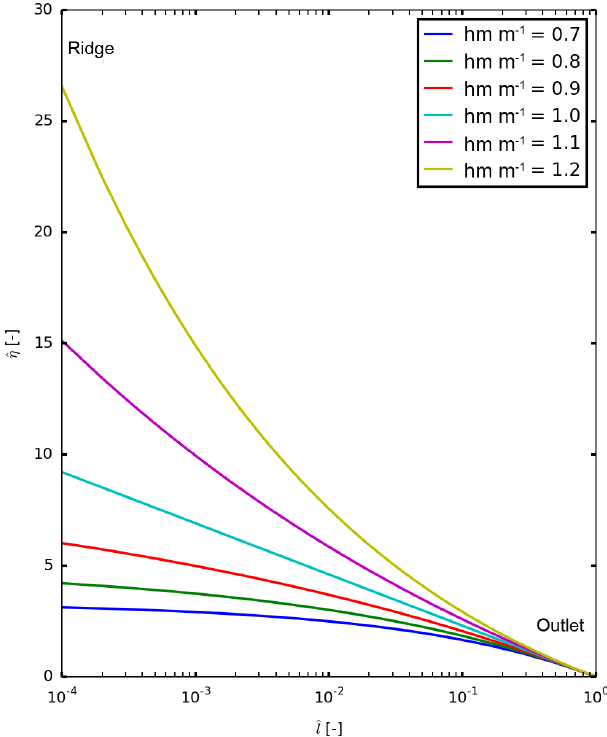
Figure 1. One-dimensional analytical dimensionless solutions for elevation profiles at steady-state equilibrium over a range of ra- tios hm/n (Hack’s Law) = 0.7, 0.8, 0.9, 1.0, 1.1, and 1.2 and P 1-D =